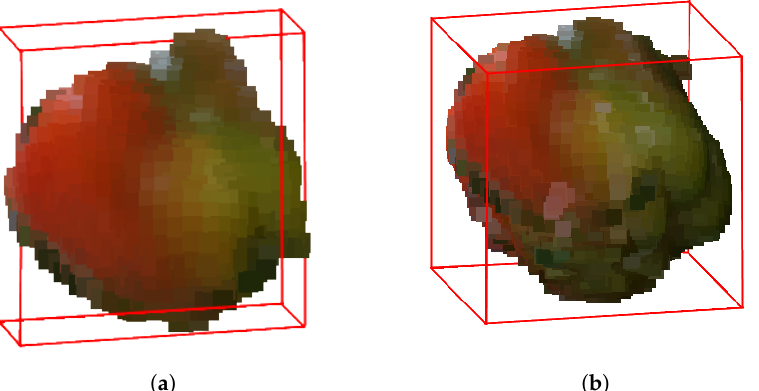
Figure 5. Example point clouds of one red pepper from one viewpoint ( a ) and all six viewpoints combined ( b